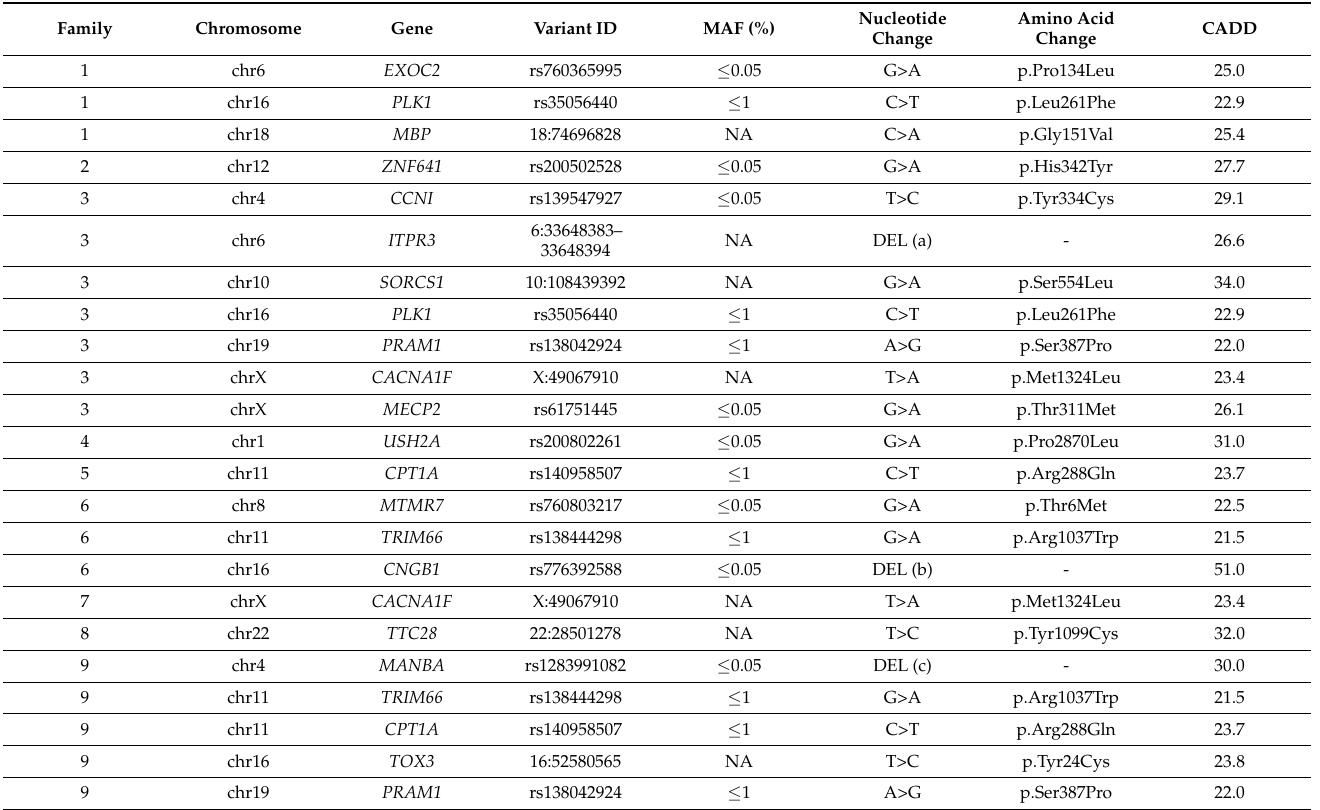
Table 2. Rare genetic variants selected for validation. An overview of the variants that were selected according to our criteria for nine multi-incident MS families. All variants are non-synonymous substitutions, resulting in missense variants, apart from three loss-of-function variants constituting a deletion (DEL) of seven-15 nucleotides. Variants with a reference SNP identifier (rs ID) are known to NCBI’s dbSNP database (v150). For these variants, minor allele frequencies (MAFs) are mentioned. If a variant is novel, frequencies are indicated as NA (not available). Both nucleotide and amino acid changes are provided for each identified variant (where applicable), as well as the Combined Annotation Dependent Depletion score (CADD). The criteria for selection of each of the individual variants are shown in Table S1.